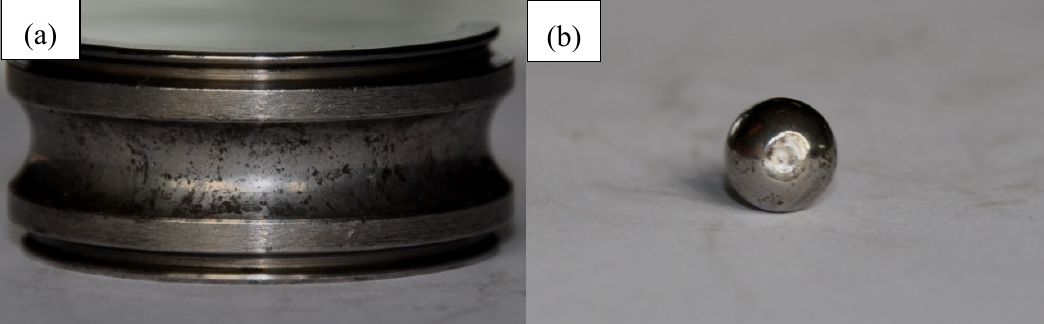
Figure 9. HS right bearing faults: ( a ) inner race fault; ( b ) ball fault.